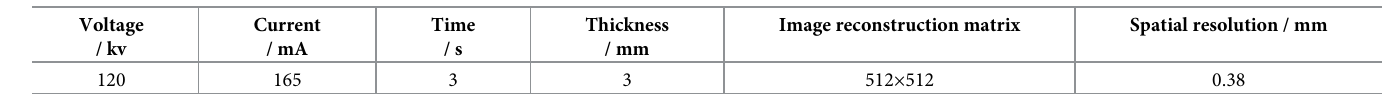
Table 1. The technical parameters of the CT